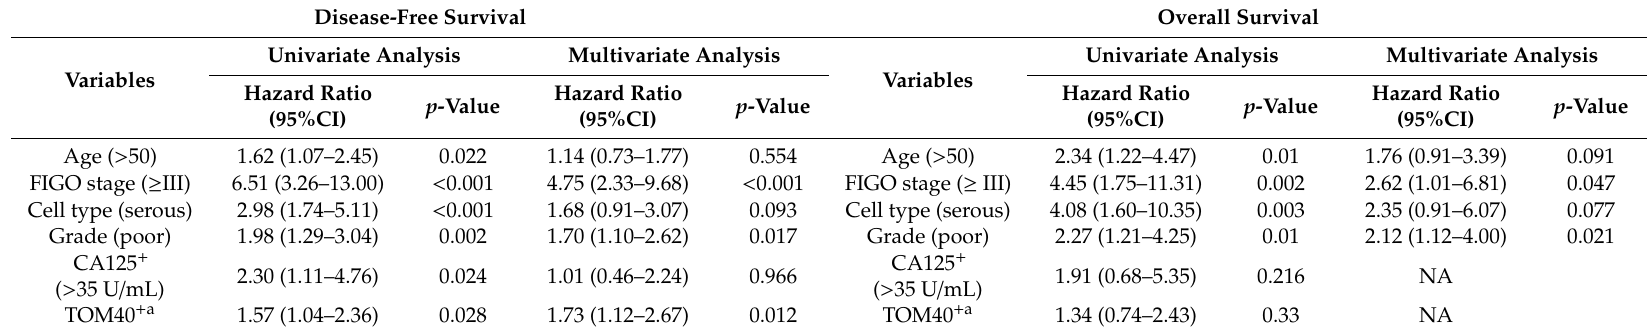
Table 2. Univariate and multivariate analyses of disease-free survival and overall survival in epithelial ovarian cancer